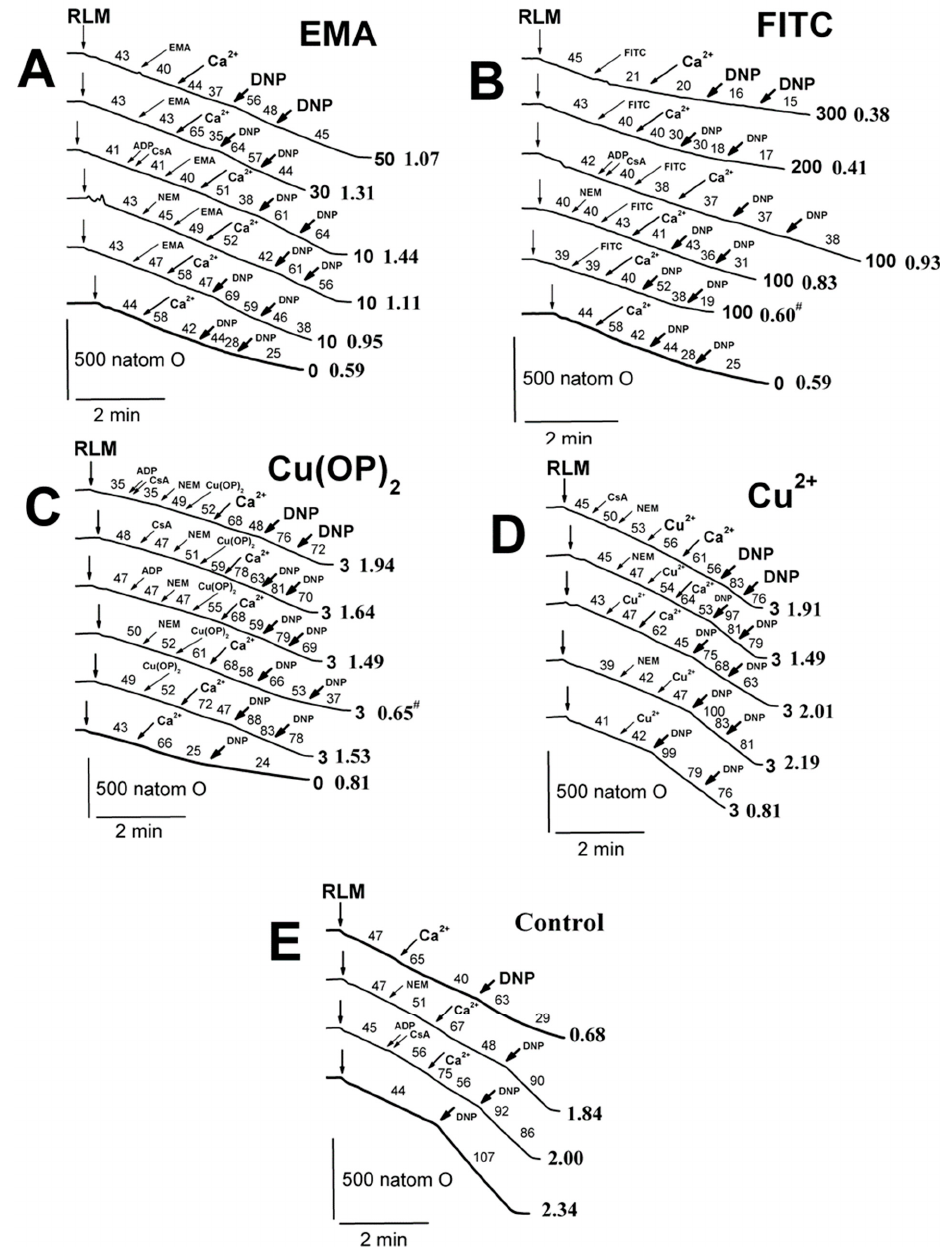
Figure 10. Influence of EMA, FITC, Cu(OP) 2 , Cu 2+ and Ca 2+ on the oxygen consumption rates of rat liver mitochondria in the medium with 75 mM TlNO 3 . Mitochondria (1.5 mg/mL of protein) were injected into the medium A containing 5 mM succinate. Arrows show additions of mitochondria (RLM), 0–50 µ M EMA (EMA), 0–300 µ M FITC (FITC), 0–3 µ M Cu(OP) 2 (Cu(OP) 2 ), 3 µ M Cu 2+ (Cu 2+ ), 75 µ M Ca 2+ (Ca 2+ ), 500 µ M ADP (ADP), 1 µ M CsA (CsA), 50 µ M NEM (NEM), and double 15 µ M DNP in total (DNP). The numbers on the right of the traces show concentrations ( µ M) of EMA ( A ), FITC ( B ), Cu(OP) 2 ( C ), Cu 2+ ( D ), and free of thiol-modifying agents ( E ). Oxygen consumption rates (natom O min/mg of protein) are presented as numbers placed above experimental traces. Numbers on the right of the traces in Times New Roman and bold show the RCR DNP values (see the Section 4, and for more detail, see the Supplementary Data). Hash signs on the right of latter numbers indicate that differences between appropriate values of the RCR DNP are statistically insignificant to the values found in experiments free of EMA, FITC, Cu(OP) 2 , and Cu 2+